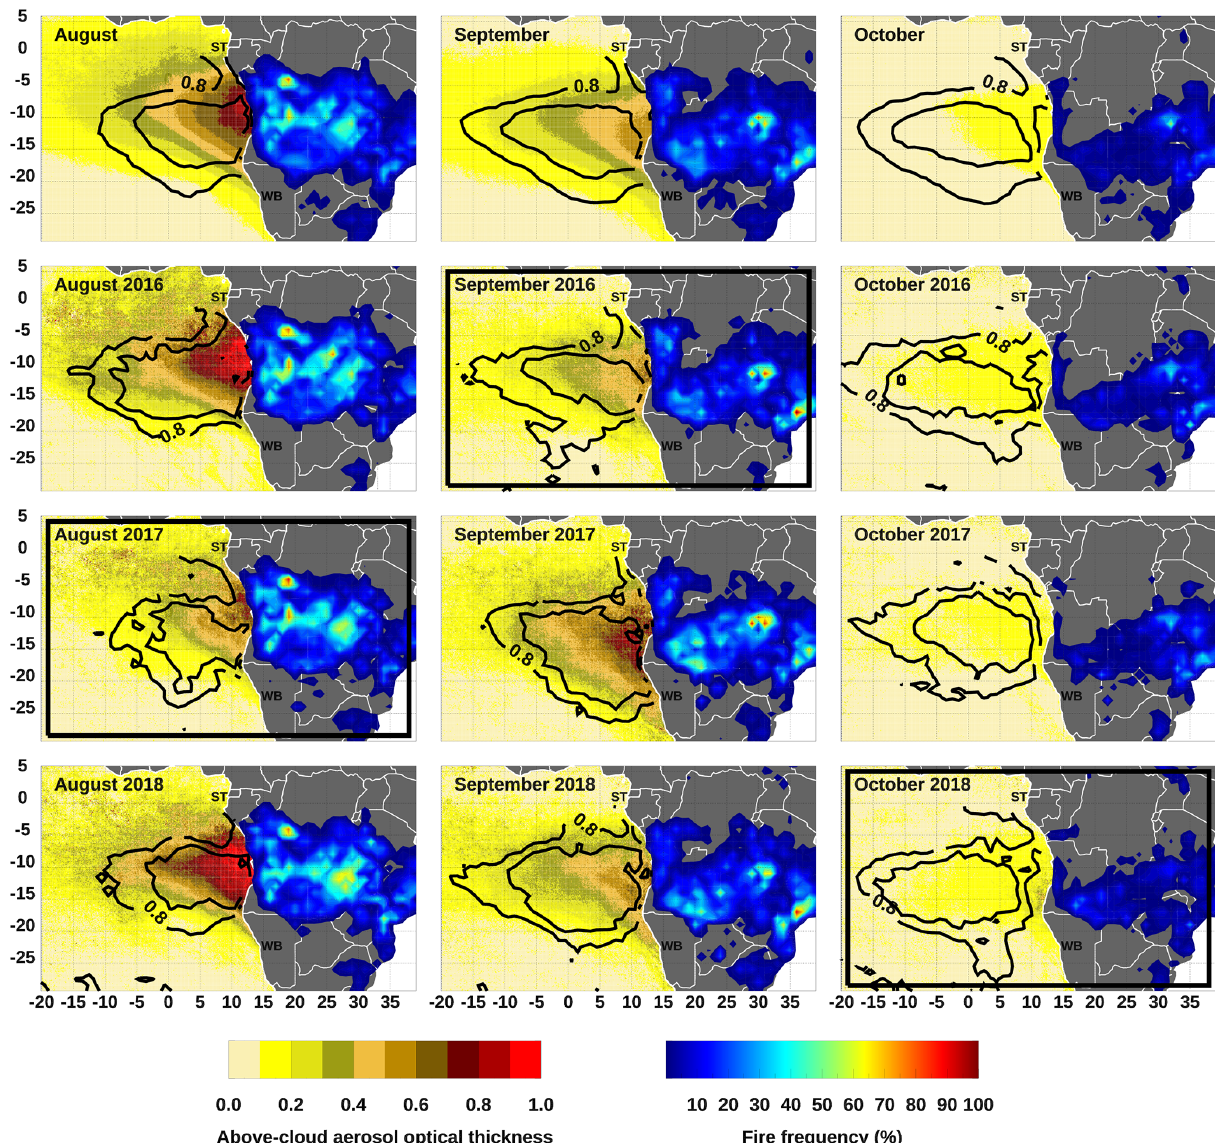
Figure 9. Combined Terra–Aqua data for August, September, and October, aggregated at 0.1 ◦ . Yellow to red shading over water indicates above-cloud AOD, black open contours indicate low-level (cloud top below 2.5km) cloud fraction of 0.8 and 0.9, and color shading over land indicates MODIS fire frequency for fires with detection confidence above 70%. Top row: climatologies computed over 2003–2018 (coincid- ing with the Aqua record). Second through fourth row: monthly averages for August through October 2016, 2017, and 2018, respectively. ST and WB stand for São Tomé and Walvis Bay. Bold black frames indicate ORACLES deployment